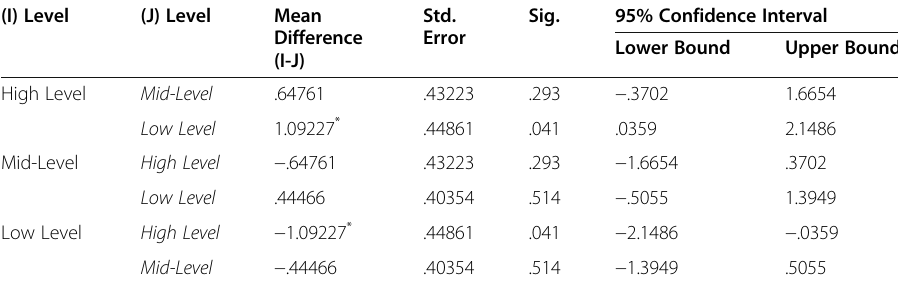
Table 5 Post-hoc Tukey HSD results for 2018 Post-Test Scores (I)